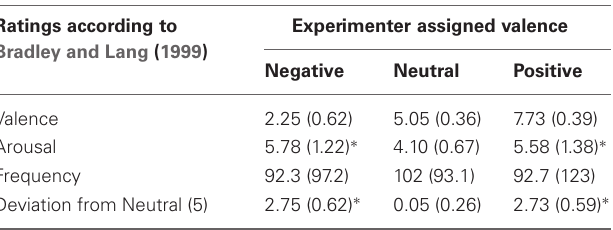
Table 1 | Characteristics of selected